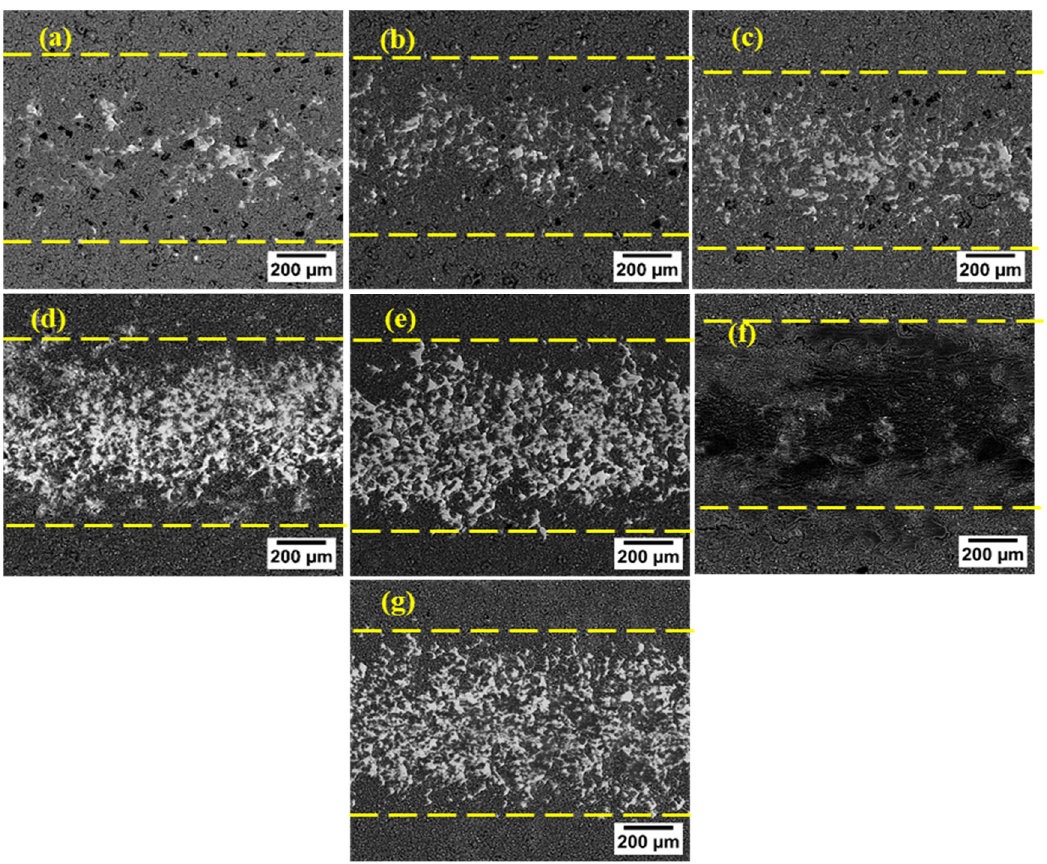
Figure 15. The SEM images of wear tracks after testing under 5 N normal load; ( a ) S1, ( b ) S3, ( c ) S5, ( d ) S7, ( e ) S9, ( f ) S11, and ( g ) S13.